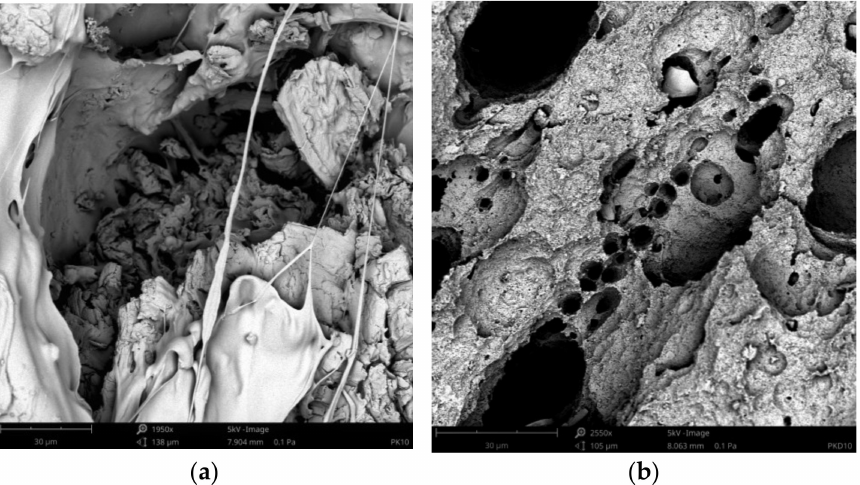
Figure 12. SEM images of sample P10 before the treatment by proteinase K ( a ) and sample P10 after the treatment by proteinase K ( b ).